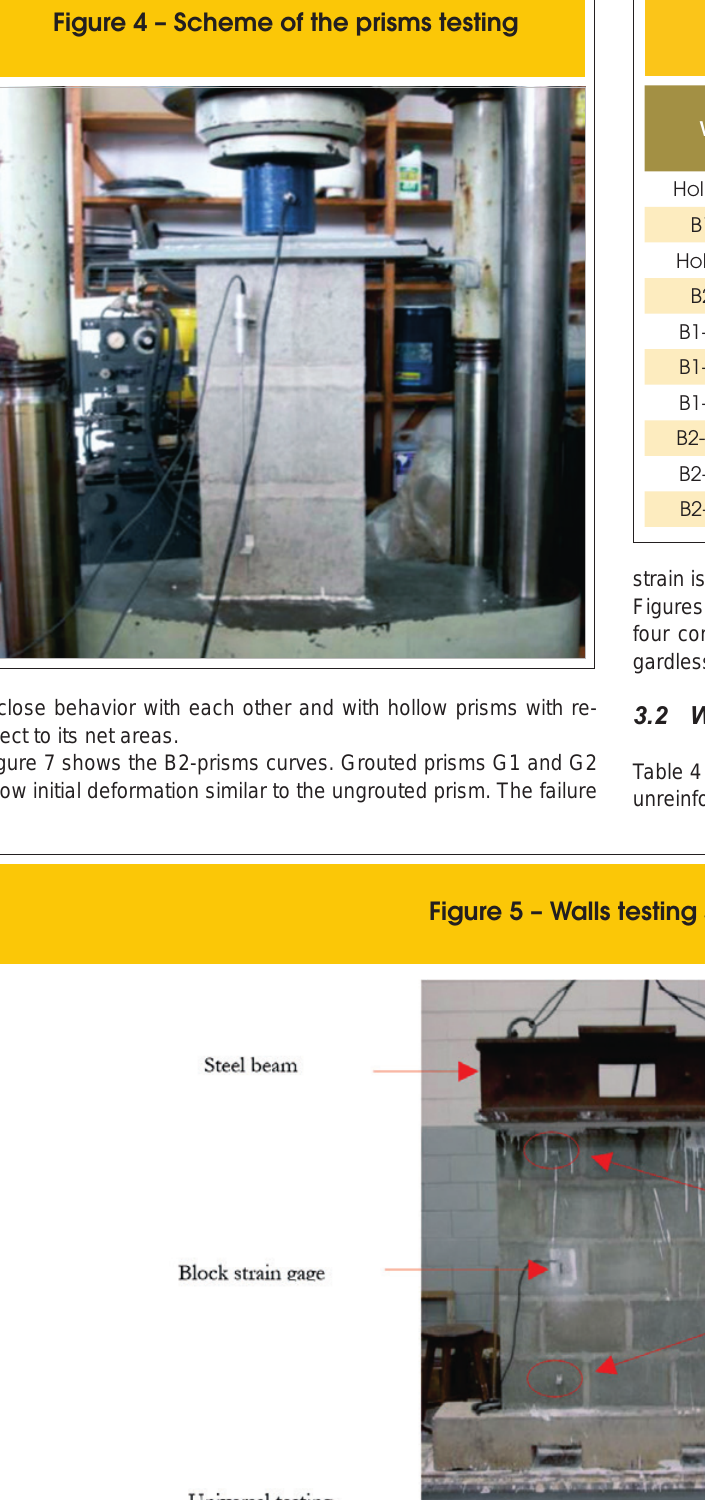
Table 4 – Results hollow, unreinforced